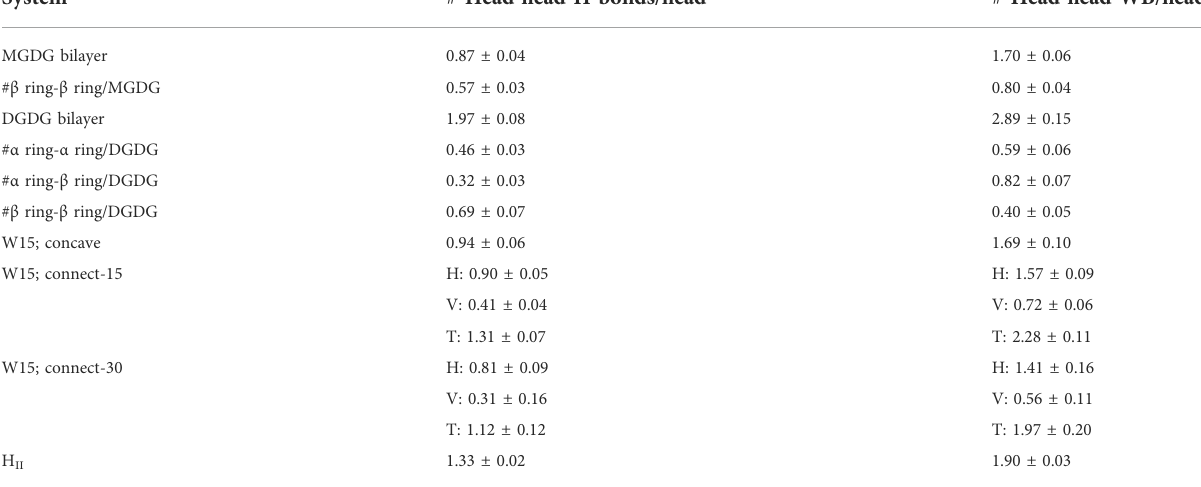
TABLE 4 Number of lipid-lipid interactions.